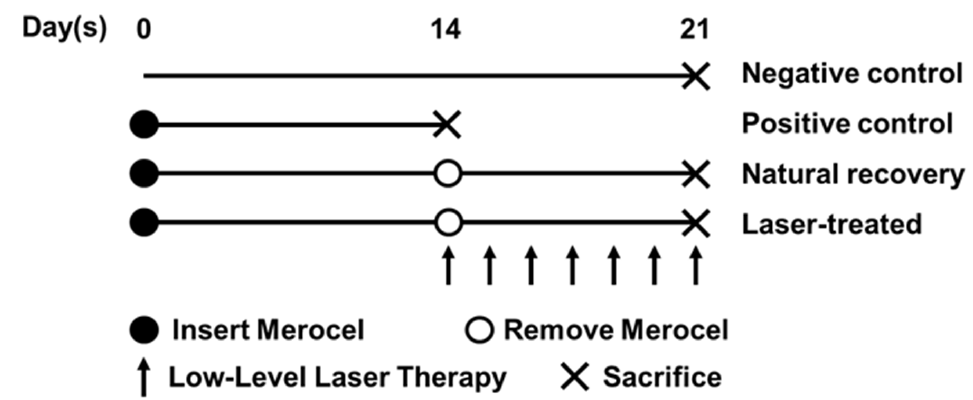
Figure 4. Experimental protocol. After 1 week of acclimatization, rabbits were divided into 4 groups: negative control group ( n = 3), positive control group ( n = 5), natural recovery group ( n = 5), and laser-treated group ( n = 5). Rabbits that were not subjected to experimental treatment (natural recovery group) and rabbits subjected to laser irradiation for one week (laser-treated group) were sacrificed on day 21.